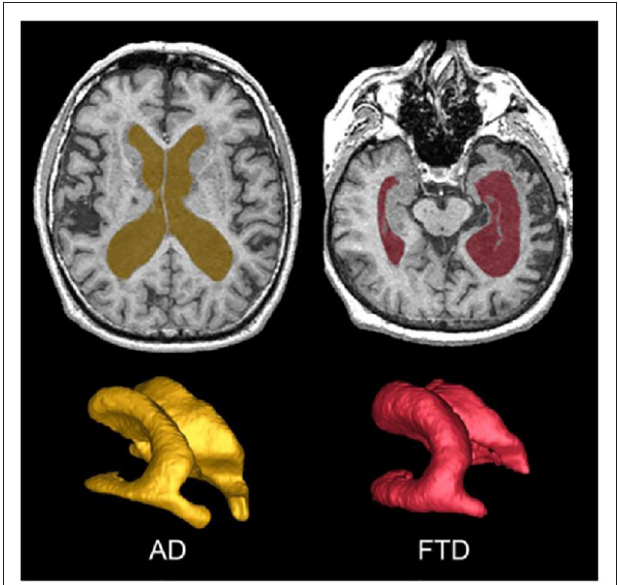
FIGURE 6 | Top row shows axial view of vCSF segmentation overlayed on T1 MRI for patients with AD (left) and FTD (right). Bottom row shows 3D surface volume renderings of the vCSF segmentation. Note the differences in ventricle size and the hemispheric differences between the two neurodegenerative diseases.